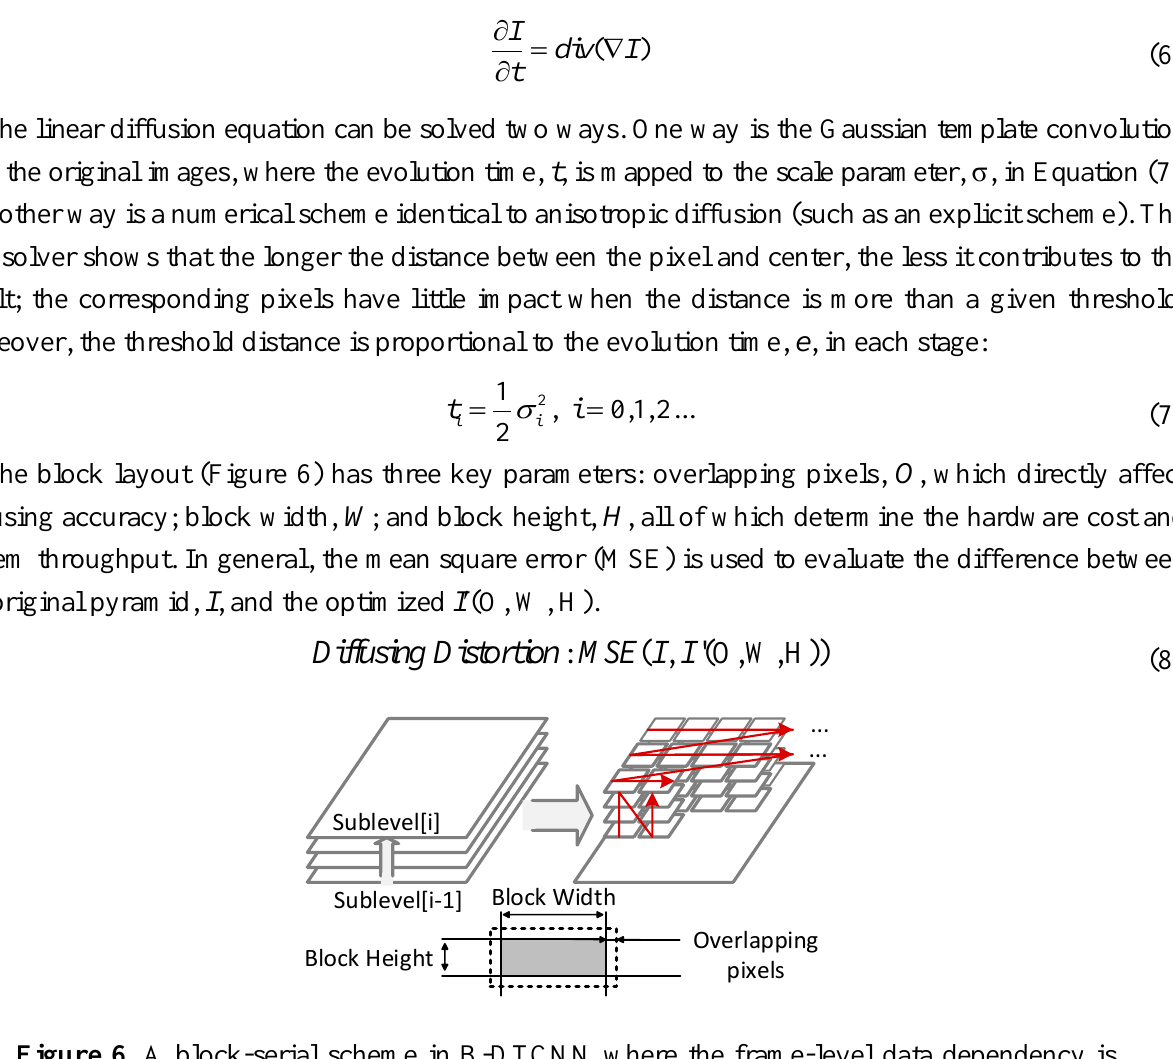
Figure 6. A block-serial scheme in B-DTCNN where the frame-level data dependency is deconstructed to block-level one. The blocks of different stages choose elastic overlapping pixels due to time steps for different trade-offs between accuracy and hardware costs because the block configure determines the size of the PE